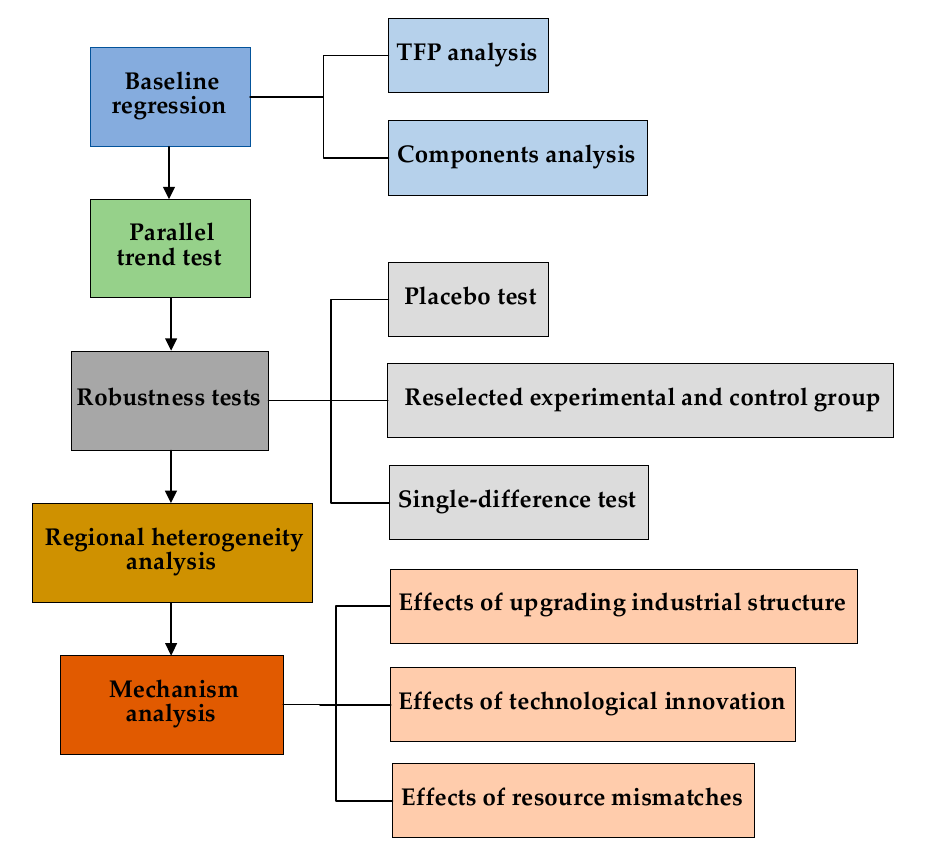
Figure 1. Research framework and process. TFP: the total factor productivity. The pilot cities of the first group in 2010 were small and mostly situated in non- representative provinces. The period for the implementation of the third group in 2017 was relatively short and the relevant data statistics were lacking. To ensure the accuracy of the evaluation, only the effects of the second group in 2012 were analyzed. To avoid the first group’s interference with the estimations, the prefecture-level cities corresponding to the first group were excluded. As limited data were available, 184 prefecture-level cities for 2006 to 2017 were selected as the sample. Finally, the following DID model for two-way fixed effects was formulated: